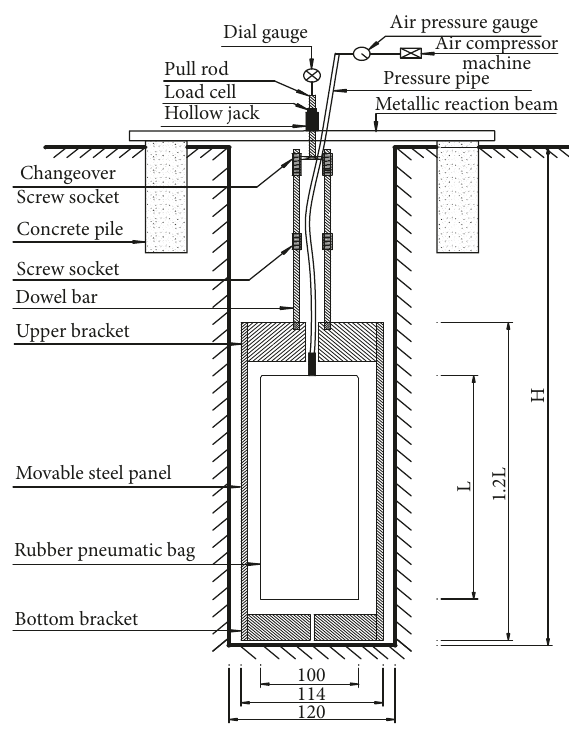
Figure 3: Pullout test setup (unit: